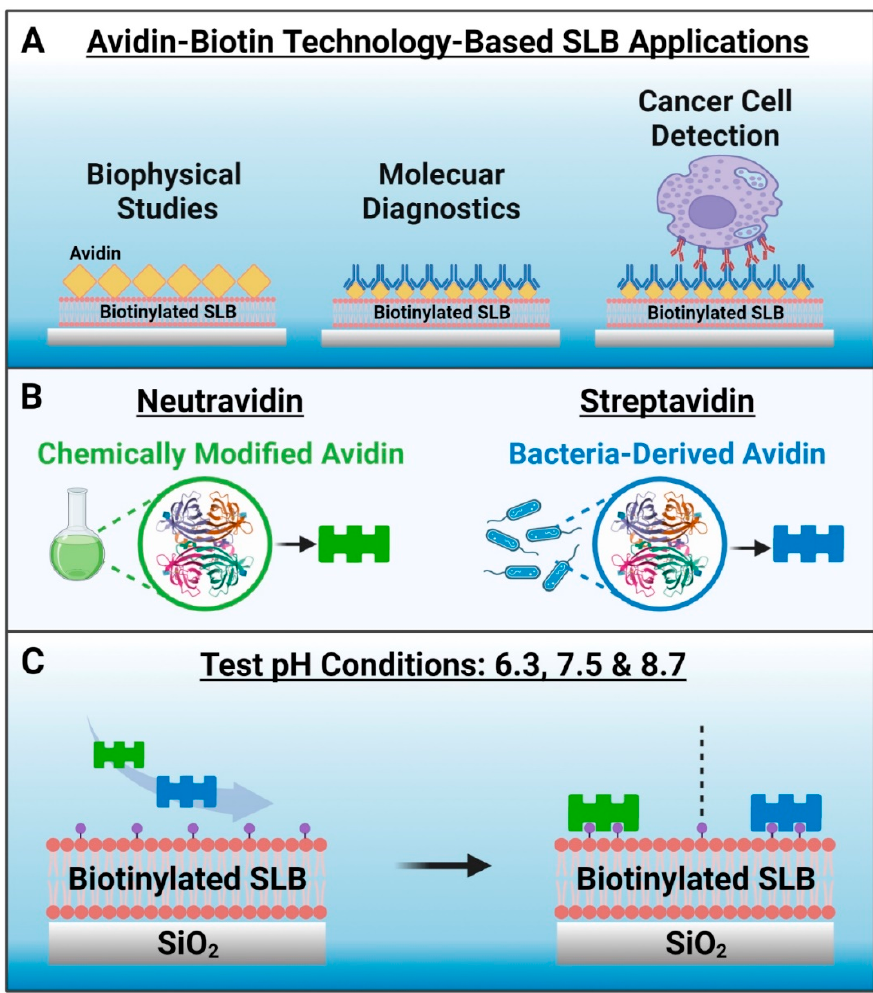
Figure 1. Conceptual overview and rationale to investigate neutravidin and streptavidin adsorption onto biotinylated supported lipid bilayer (SLB) biosensing platforms. ( A ) Examples of avidin–biotin bioconjugation strategies used in SLB-based applications. ( B ) Schematic illustrations of methods to produce neutravidin and streptavidin, which are avidin analogues. ( C ) Experimental strategy. The tested pH conditions were 6.3, 7.5 and 8.7, and the biotinylated SLB was formed on a silica surface and contained 5 mol% biotinylated lipids. Note that no Neu or Strep binding occurs to the SLB in the absence of biotinylated lipid.